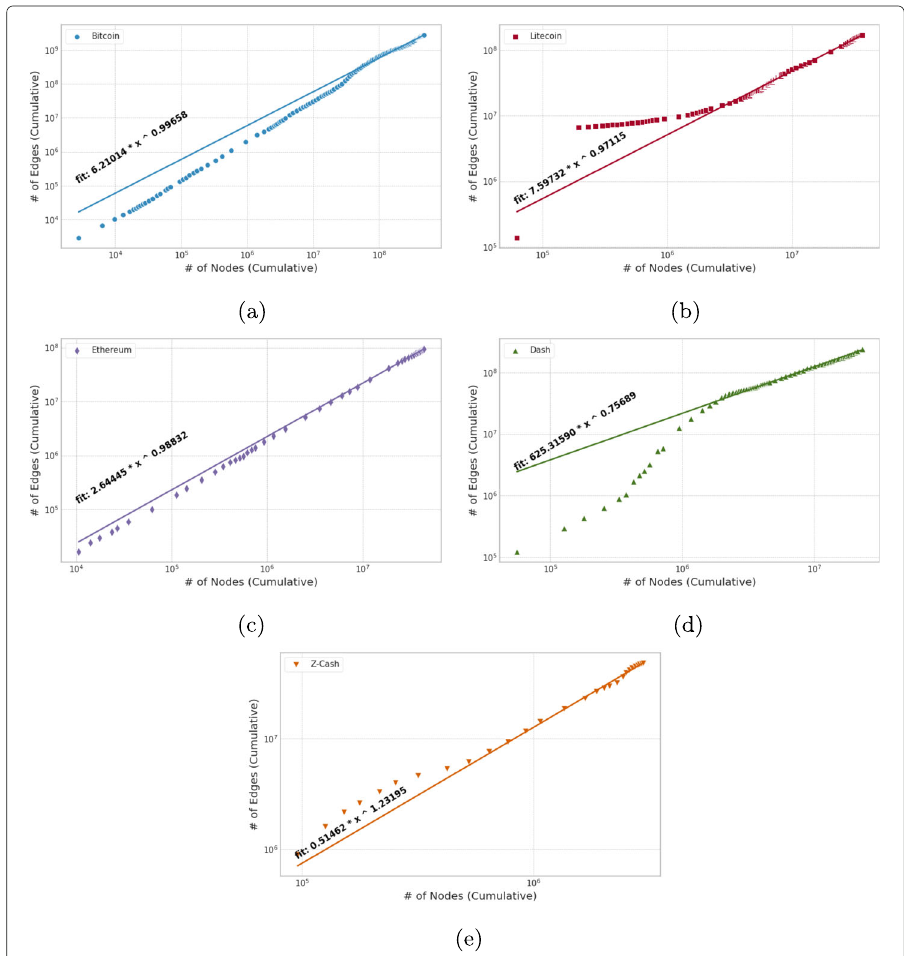
Fig. 5 Fit curve to chart of number of edges in terms of number of nodes in CMTG graph for each coin. a Bitcoin. b Litecoin. c Ethereum. d Dash. e Z-Cash